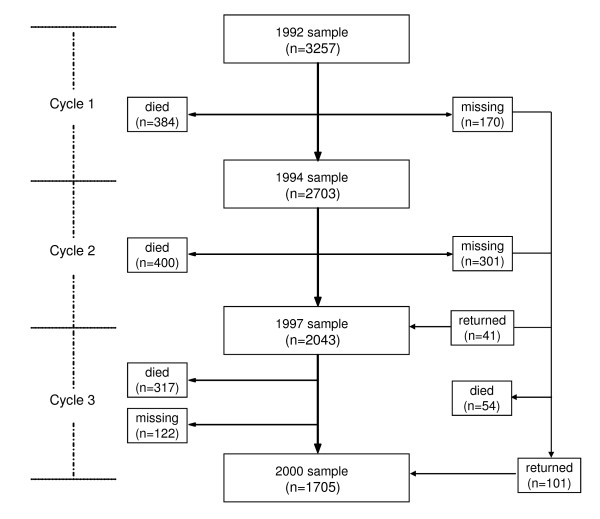
Composition of Beijing Longitudinal Study of Aging (BLSA) cohort.